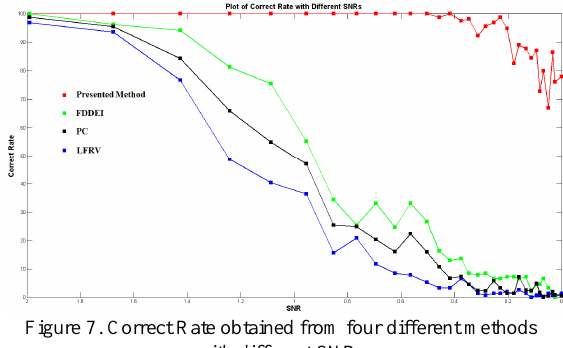
Figure 7. Correct Rate obtained from four different methods with different